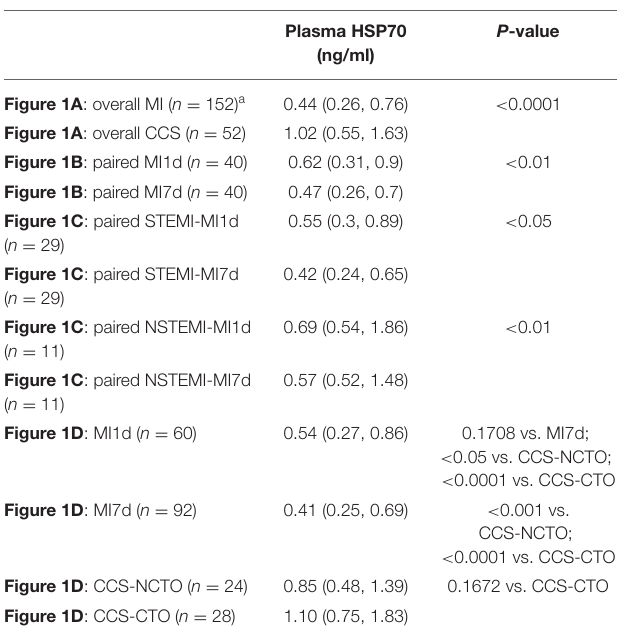
with the largest sum of sensitivity and specificity was 0.713 ng/ml (sensitivity 0.7368, specificity 0.6923), 0.452 ng/ml (0.65, 0.7738), and 1.017 ng/ml (0.3971, 0.8553),